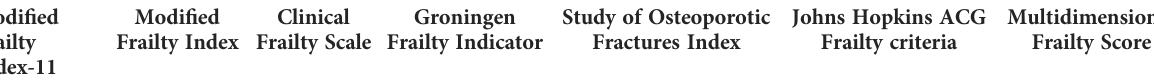
TABLE 2 Components included in different frailty